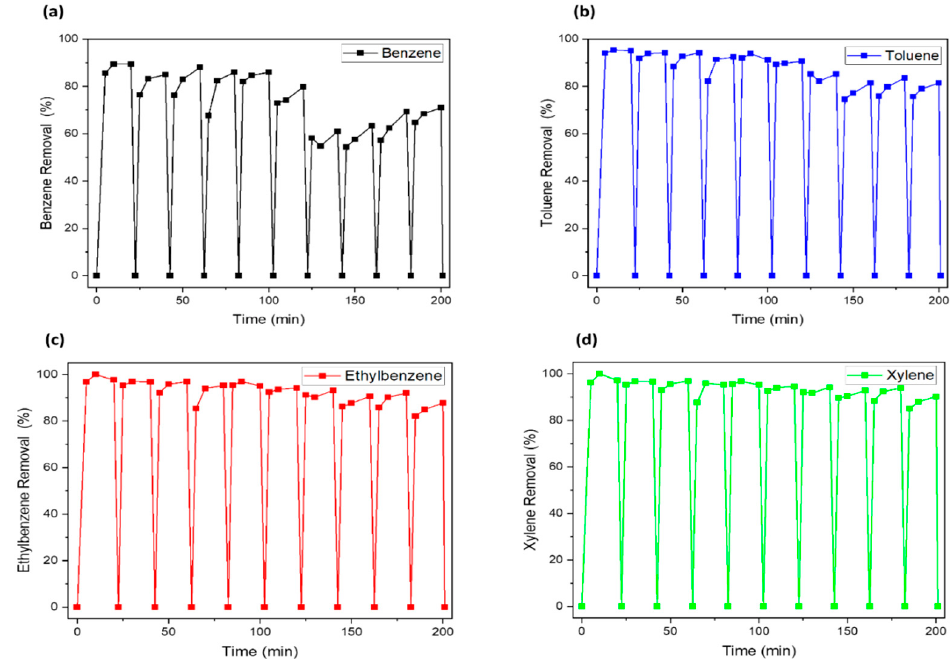
Figure 8. BTEX removal by UV–Fe 2 O 3 /SiO 2 : ( a ) benzene, ( b ) toluene, ( c ) ethylbenzene, ( d ) xylene.